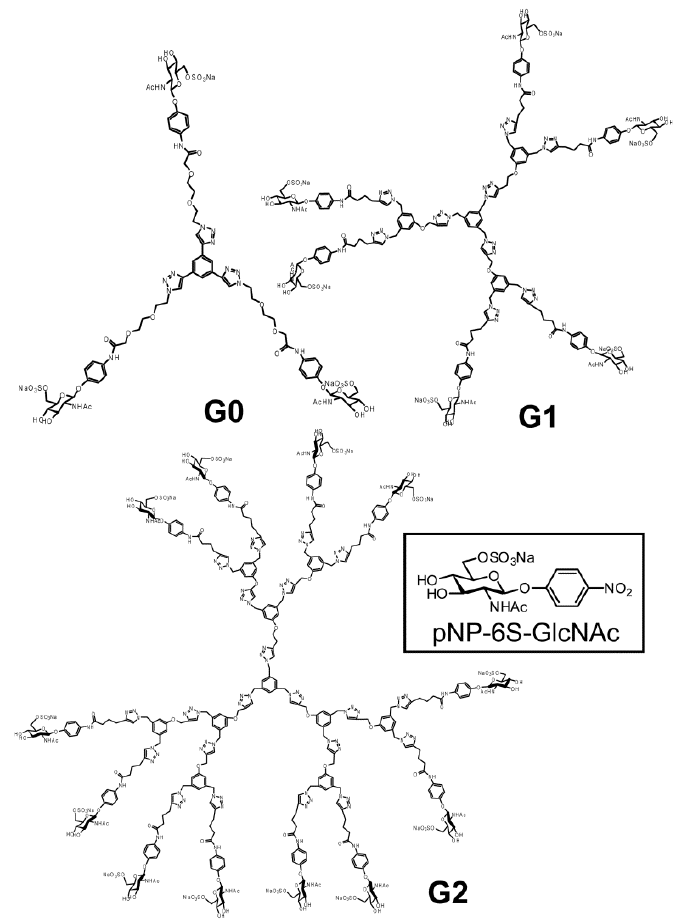
Figure 1. Chemical structures of the